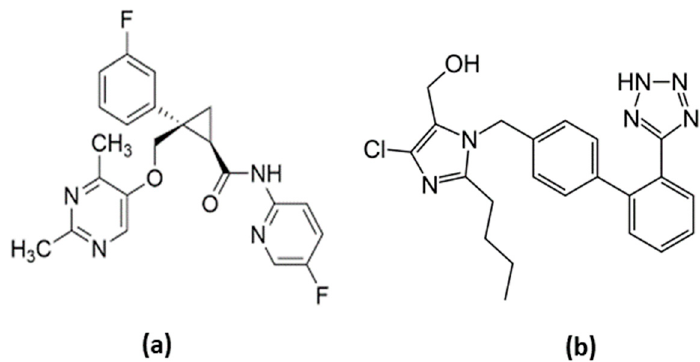
Figure 1. Chemical structure of LEM ( a ) and losartan ( b ). Table 1. Optimized UPLC-MS/MS parameters for LEM and IS.